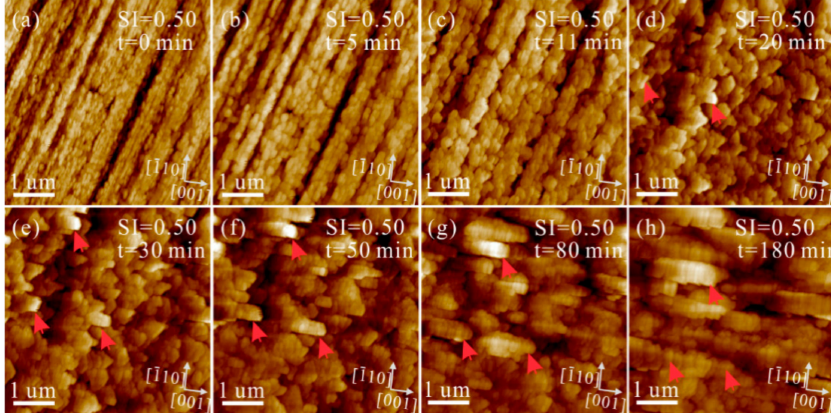
Figure 7. AFM height images of the polished aragonite (110) surface in the solution (Mg 2 + / Ca 2 + = 3, SI calcite = 0.50) under flowing conditions at pH = 8.0 ± 0.1 for ( a ) 0, ( b ) 5, ( c ) 11, ( d ) 20, ( e ) 30, ( f ) 50, ( g ) 80 and ( h ) 180 min.